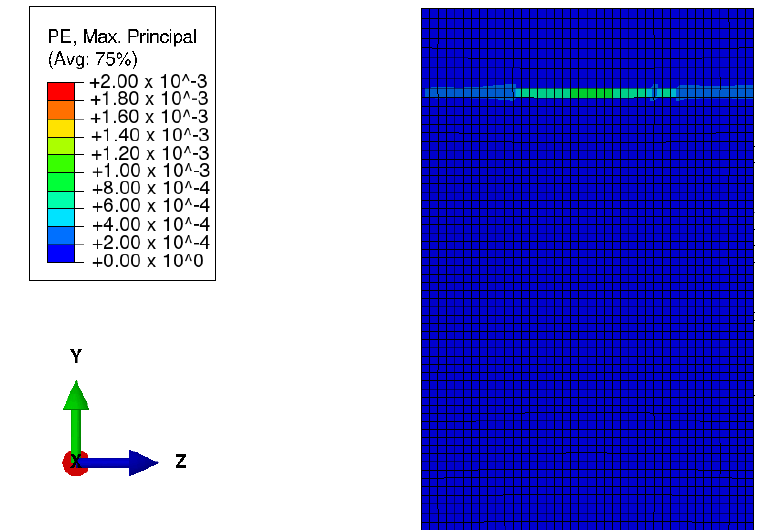
Figure 21. Plastic strains, developed on the outer surface of the top slab at its connection to the lateral wall right before the onset of cracking, as obtained from a thermomechanical simulation based on temperature-dependent and elasto-plastic material behavior, as well as on the prescription of one uniform surface temperature history; the results refer to the time instant six minutes and 3.4 s after the beginning of the fire test.